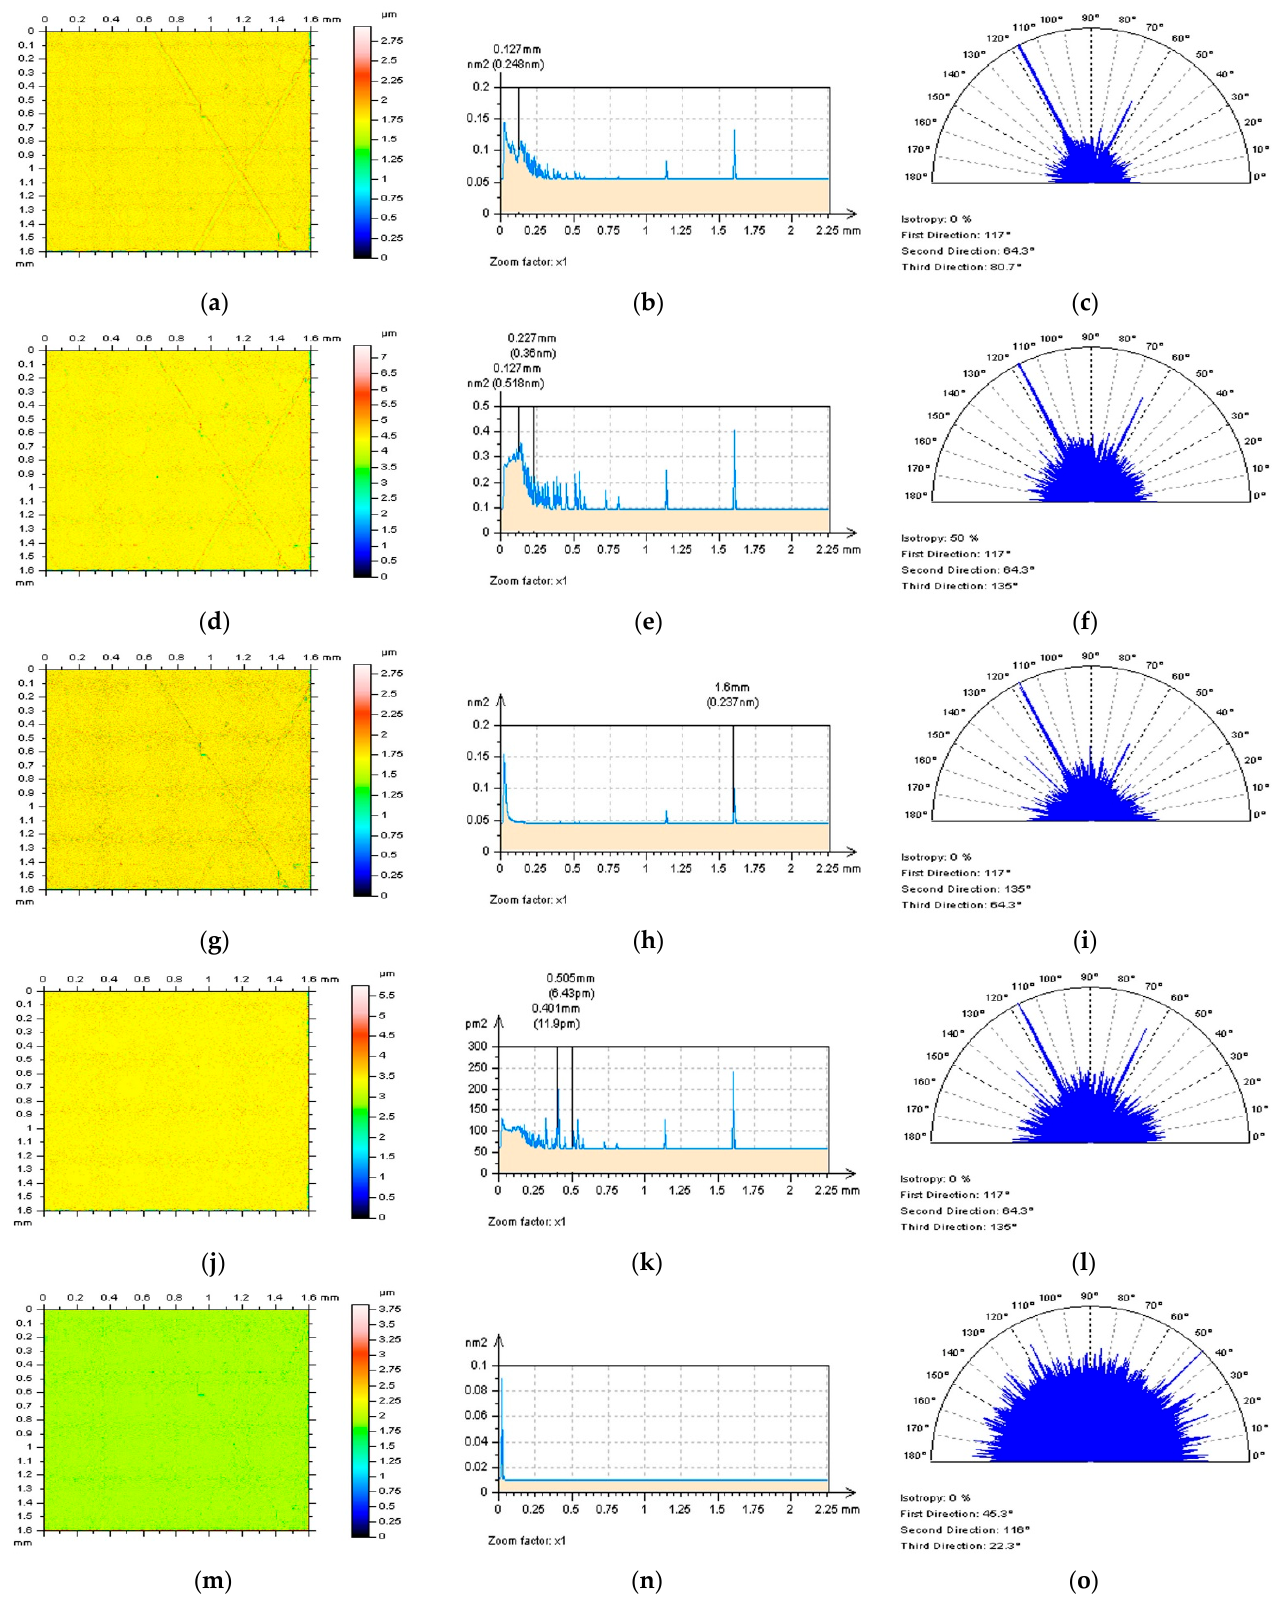
Figure 6. Analysis of a HFNS (left column), their PSDs (middle) and TDs (right column) received from a turned piston skirt surface by application of: GF ( a – c ), RGF ( d – f ), SF ( g – i ), MDF ( j – l ) and FFTF ( m – o ) method, cut–off = 0.025 mm.